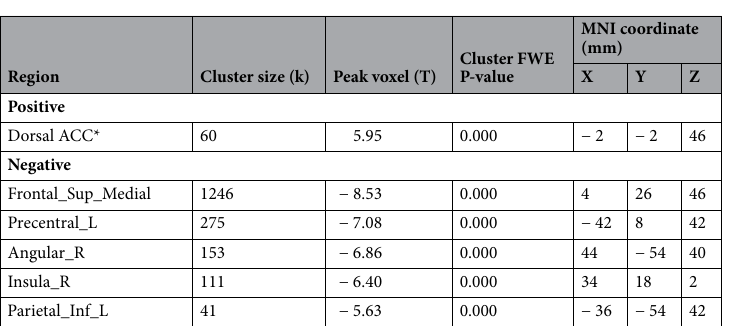
Table 1. Clusters showing correlation with CSI 2–0 (Critical Success Index), with age, sex, years of education as covariates. ACC anterior cingulate cortex, R right, L left.